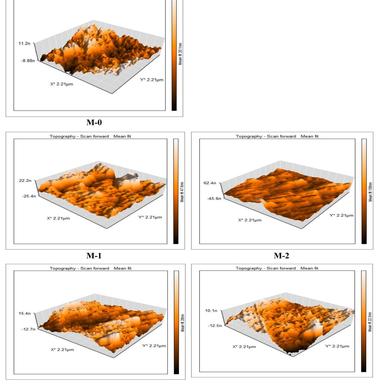
AFM images of fabricated composite membranes: M-0 (bare PES), M-1 (0.01 wt%), M-2 (0.03 wt%), M-3 (0.05 wt%), M-4 (0.07 wt%).